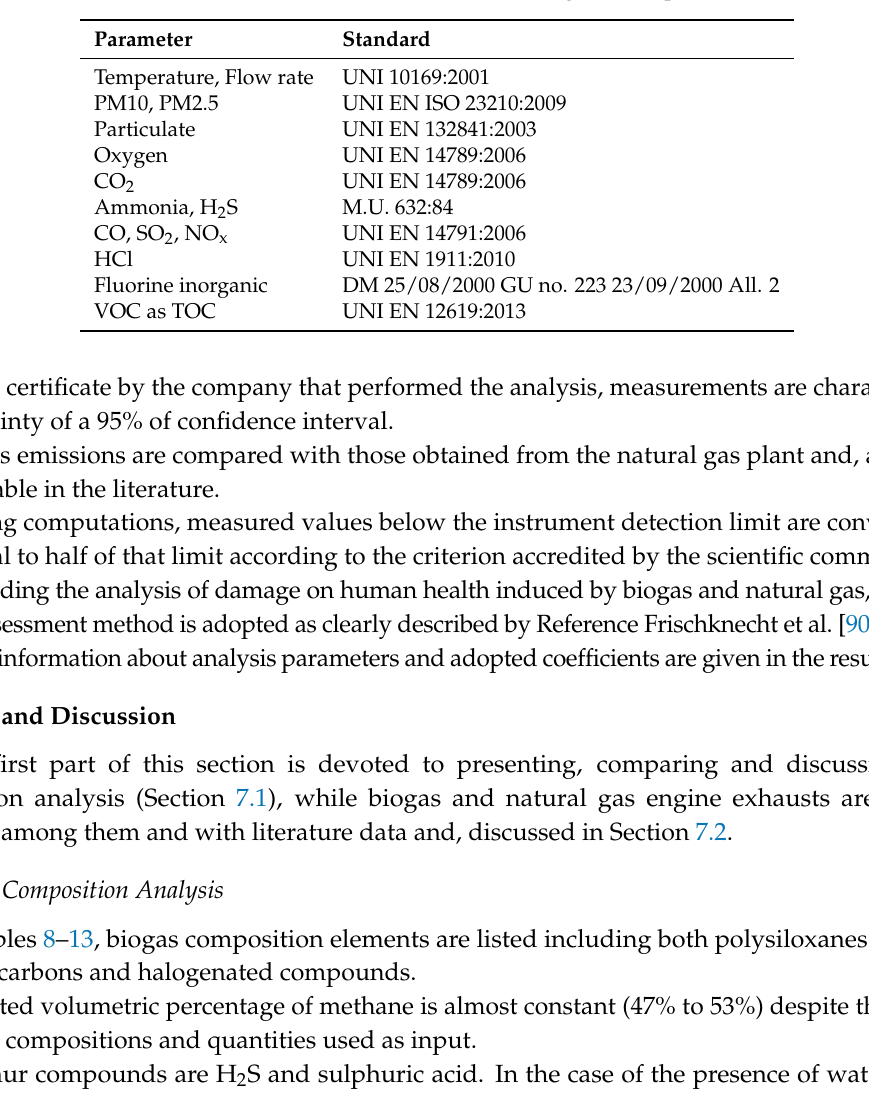
Table 7. Standards used to measure exhaust gases